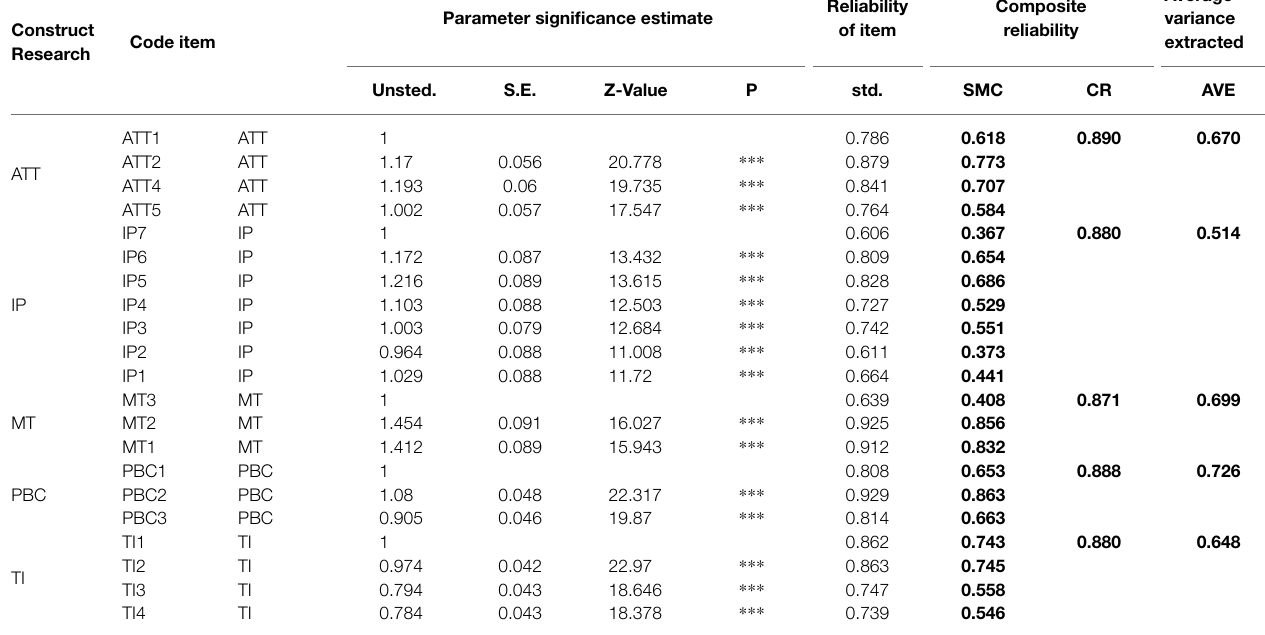
TABLE 3 | Measurement